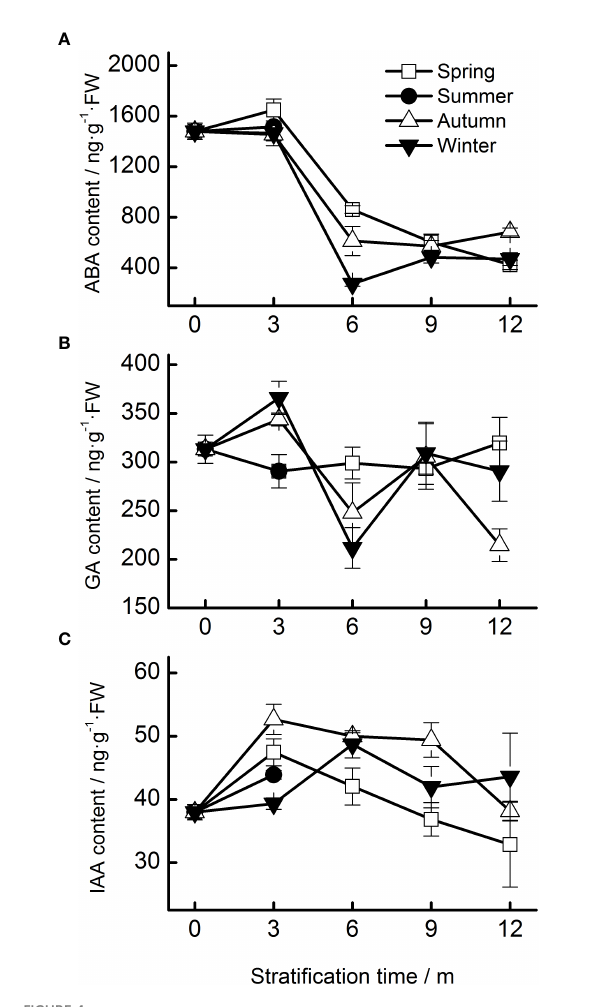
FIGURE 4 Endogenous hormone contents ( A , ABA; B , GA; C , IAA) of Taxus chinensis var. mairei seeds under strati fi cation at four seasonal temperature regimes. The vertical bars represent standard errors of the mean (n = 3). ABA, abscisic acid; GA, gibberellic acid; IAA, indole acetic acid.